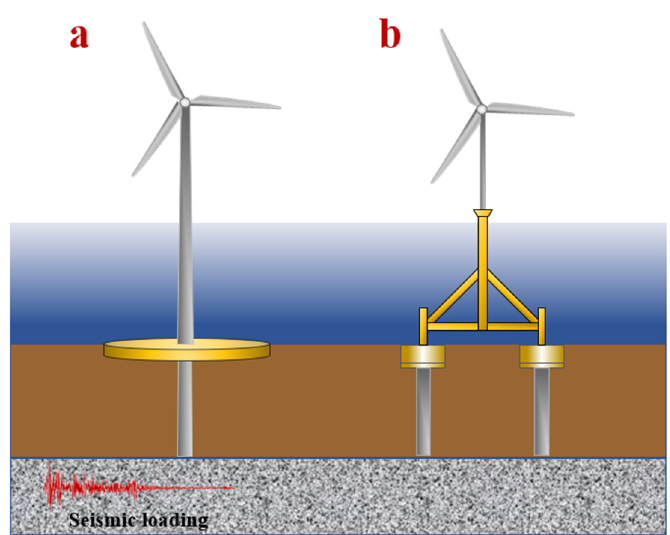
Figure 6. New structures of monopile foundation to increase liquefaction resistance: ( a ). hybrid monopile; ( b ). tripod foundation (based on [74,75]).